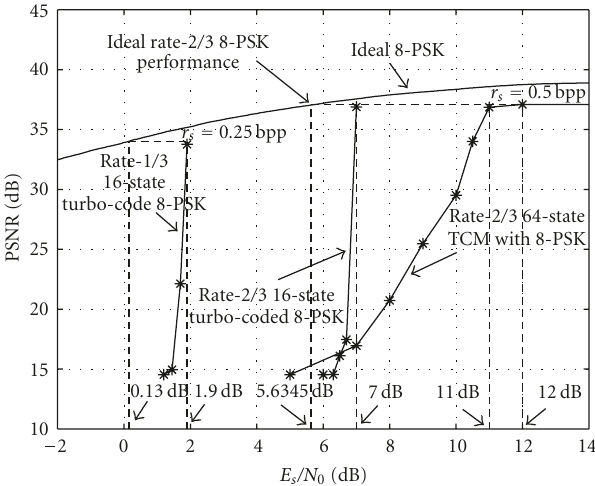
Figure 7: PSNR versus E s /N 0 performance of using rates 1/3 and 2/3 turbo coded 8-PSK for transmitting the SPIHT compressed 512 coding rate is 0.25 and 0.5bpp, respectively.